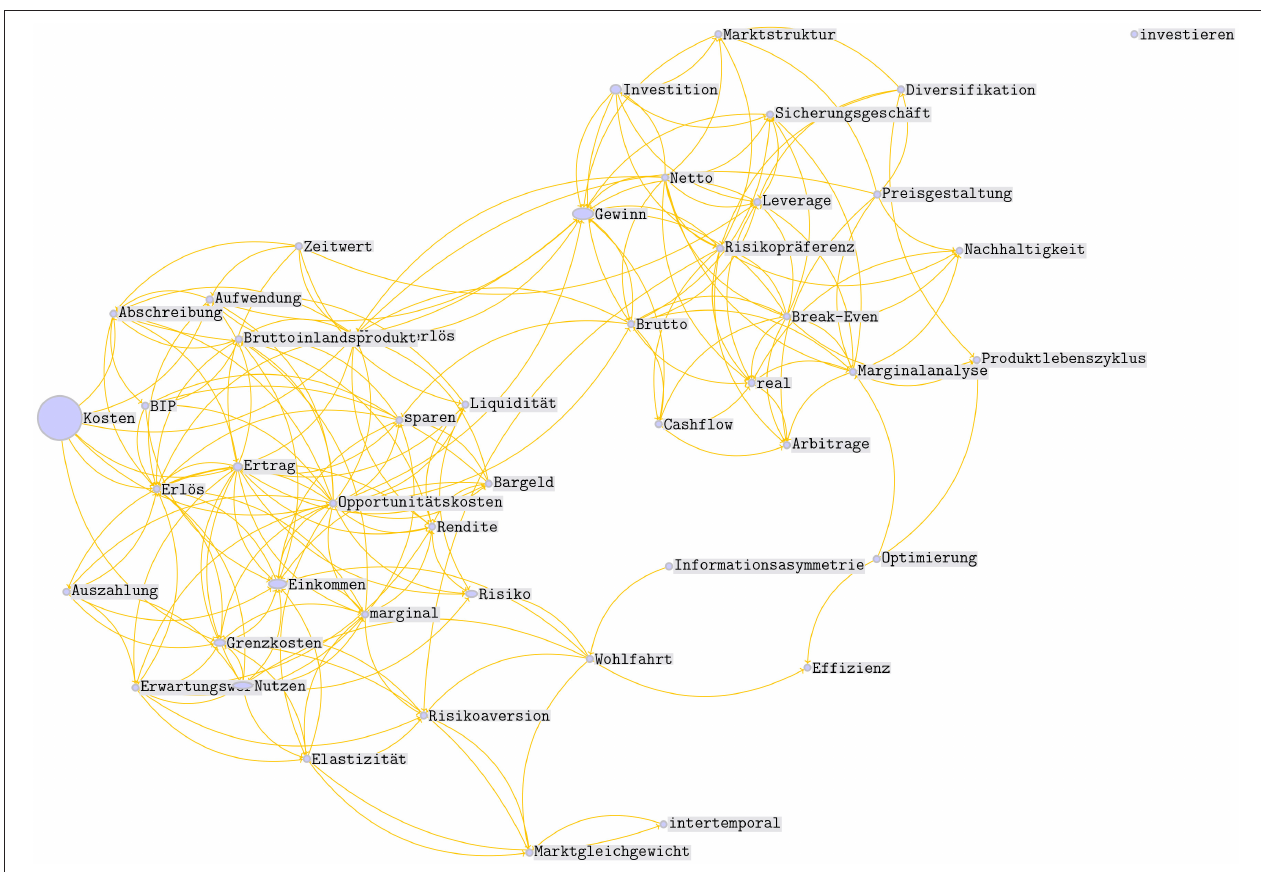
FIGURE 6 | Alpha-cut graph C ( T , α ) of the TCN based on TB for α = 0.7. Vertex height: compounding-specificity; vertex width: sentence-specificity. For the vertices’ translations see Appendix A